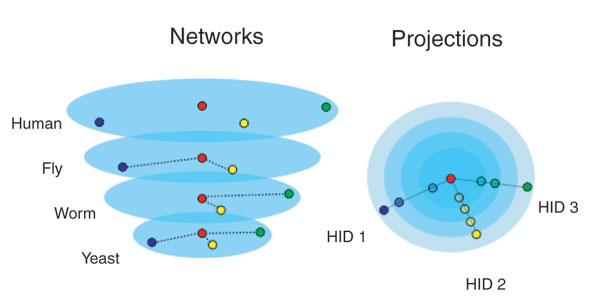
Interologs mapping of conserved protein networks across multiple species (each plane corresponds to a species). Orthologous proteins are defined and protein interactions identified in each model organism. Virtual human protein networks are generated by projecting the observed interactions across all planes onto homologous human genes. HID, HomoloGene identifier.